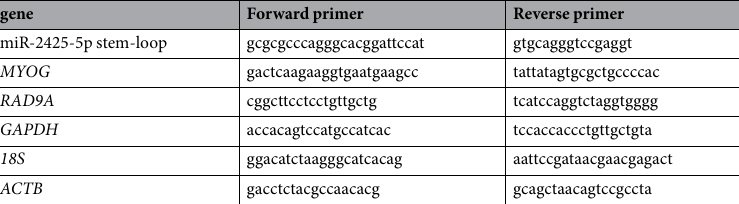
Table 3. Primers used for SYBR green quantitative